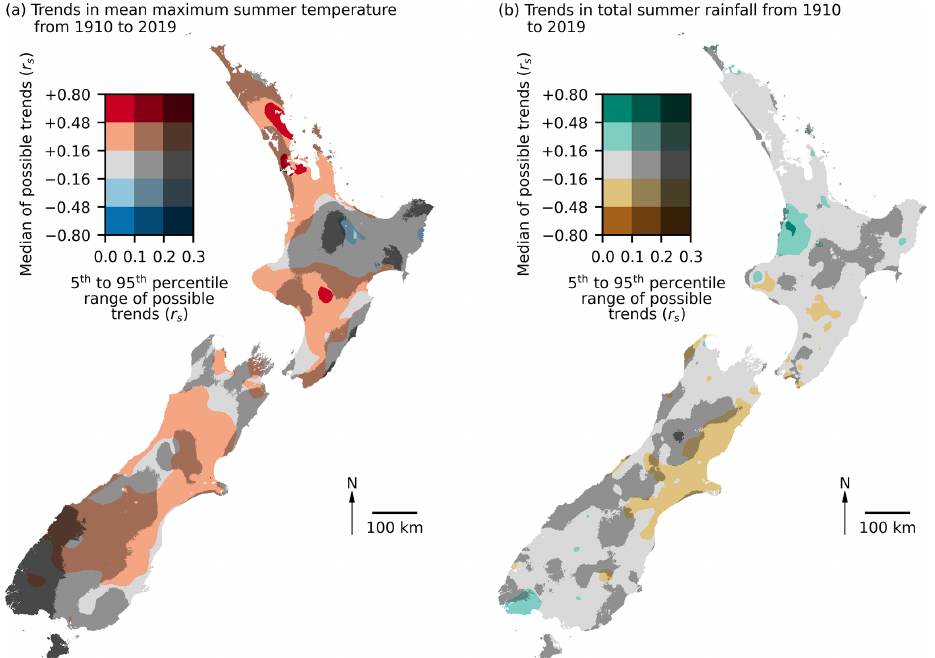
Figure 9. Spatial uncertainty analysis for the summer months (December, January, and February) trends in (a) mean maximum temperature, and (b) total rainfall across New Zealand. Trends were calculated as a Spearman’s Rank ( r s ) between temperature or rainfall and time from 1910 to 2019 for 100 possible histories that were within the range of uncertainty for the interpolated values for each month. The median r s value is visualised as a diverging colour scheme indicating positive or negative trends in temperature and rainfall. Uncertainty is visualised by the 5th to 95th percentile range of r s values as a measure of uncertainty such that darker shades of each colour indicate areas with greater